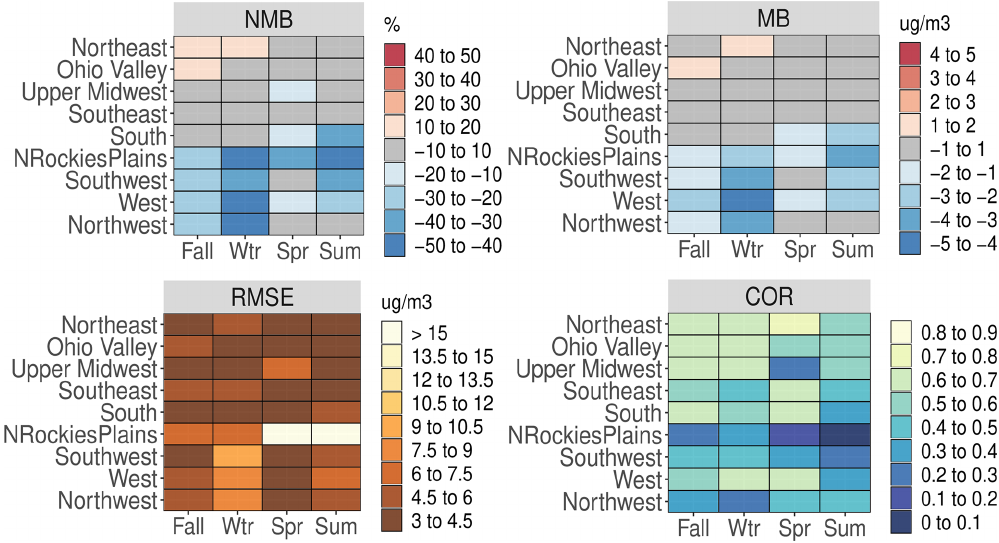
Figure 3. NMB (%), MB (µgm − 3 ), RMSE (µgm − 3 ), and Pearson correlation coefficient (COR) values for daily average PM 2 . 5 for all AQS sites based on season and NOAA climate region for the CMAQ521 simulation.